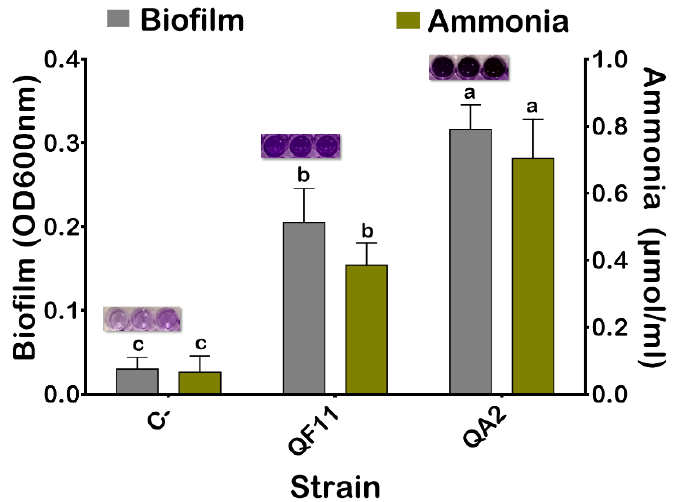
Figure 3. Biofilm and ammonia production by QA2. The values represent means of three replicates ± standard deviations. Uninoculated TSB media and QF11( Enterobacter asburiae ) were used as negative (C − ) and positive controls. Error bars represent standard errors for three samples from three replications. Letters in superscript indicate the significant difference to the control (C−) at 95% between treatments.